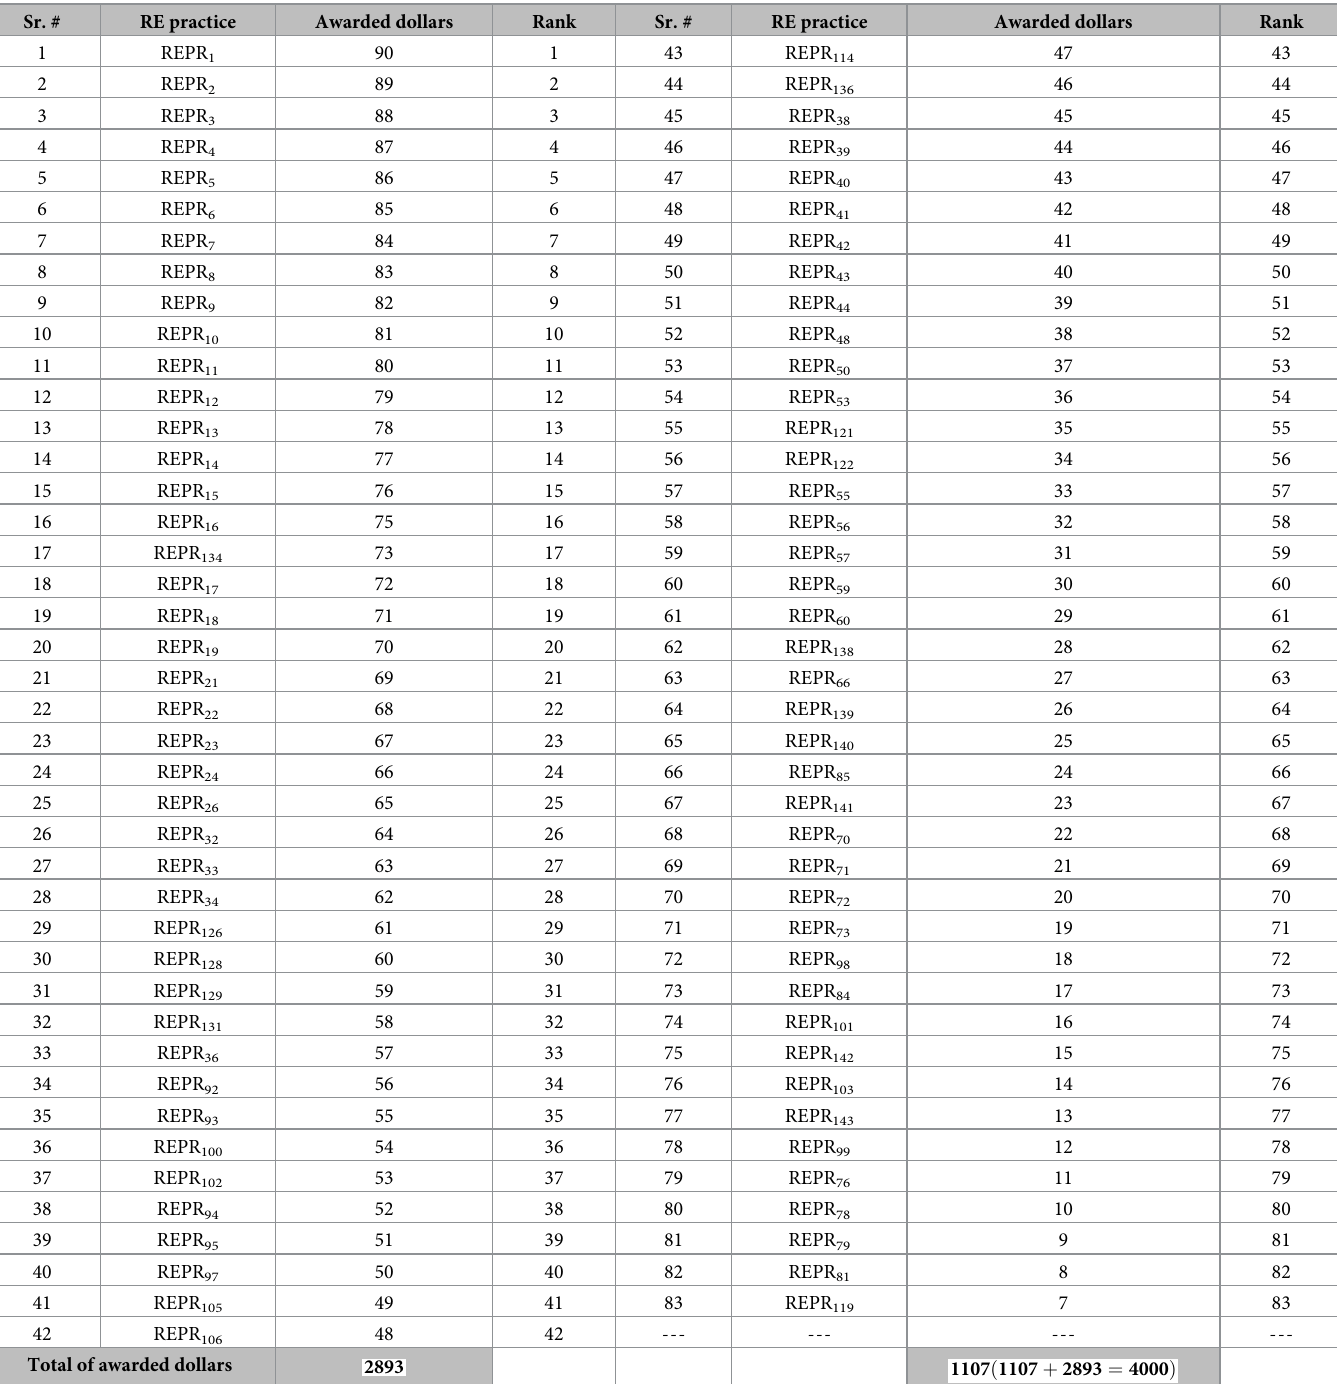
Table 5. RE Practices belonging to ‘High’ importance group along with respective ranks within group. Sr.